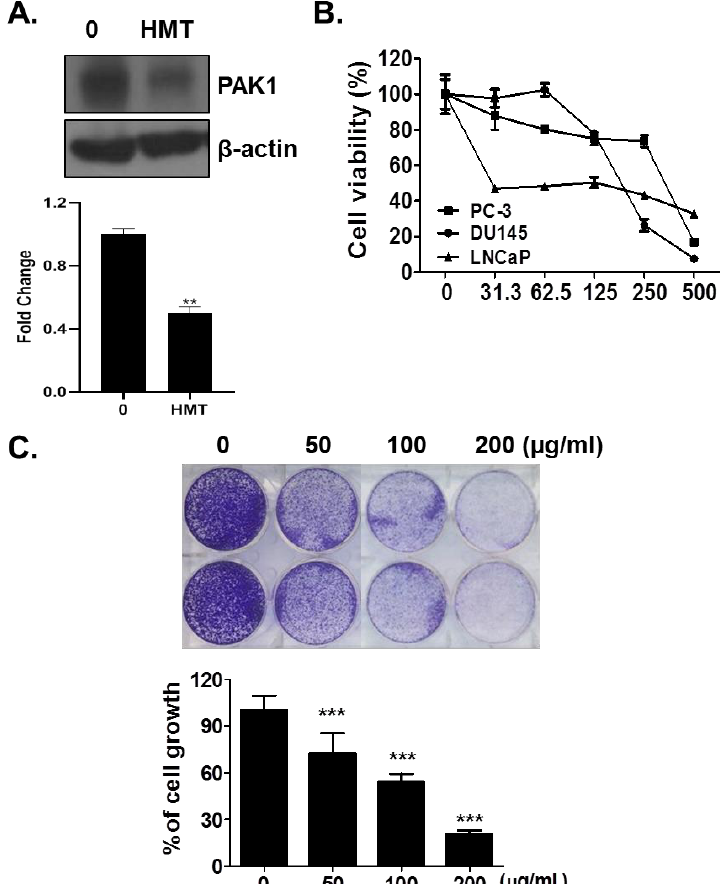
Figure 1. The inhibitory effect of HMT on PAK-1 expression and cell growth in PC-3 cells. ( A ) HMT- treated PC-3 cell lysates were prepared and subjected to Western blotting for PAK-1 expression. Densitometric analysis was used to evaluate the ratio of protein of interest to β-actin, and results are presented as fold change of the control. Data represent mean ± SD. ** p < 0.01 compared with control. ( B ) Cells (LNCaP, DU-145, and PC-3 cells) were treated with various concentrations of HMT for 24 h, and cell viability was measured by using CELLOMAX viability kit. Data represent mean ± SD. ( C ) The antiproliferation activity, cell growth, for long-term treatment of HMT was carried out by cell growth crystal violet assay. PC-3 cells were treated with HMT (50, 100, and 200 µ g/mL) for 4 days. The cells were stained with crystal violet and were photographed and resolved in 70% EtOH, and the absorbance was measured using a microplate reader. Data represent mean ± SD. * p < 0.05, ** p < 0.01, and *** p < 0.001 compared with